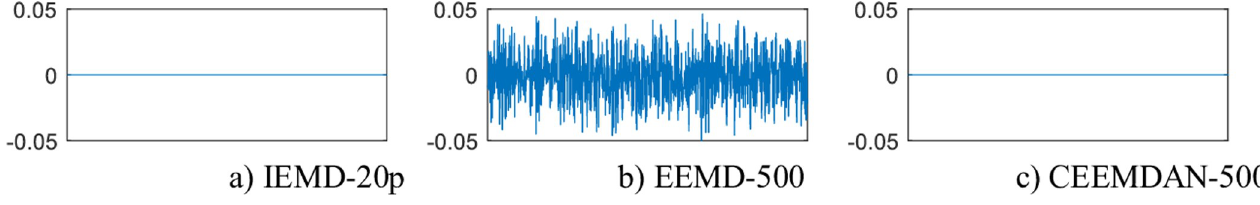
Fig 3. Waveforms of reconstruction